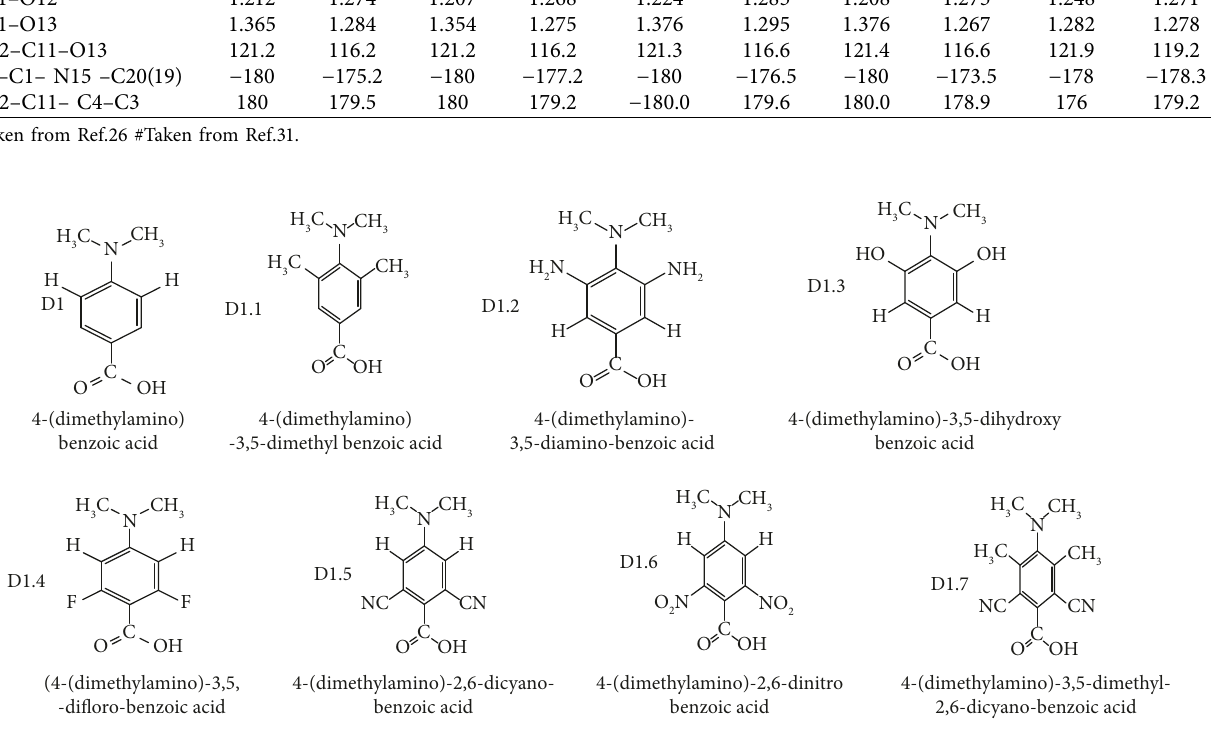
Table 1: Some selected bond lengths (˚A) bond angles ( ° ) and dihedral angles ( ° ) of gas-phase 4-DMABA (D1) and 4-DMABA-T +4 (OH) (D2) which were calculated by using B3LYP, CAM-B3LYB, PBEPBE, ω B97XD functionals, and 6–311++G ∗∗ basis set. B3LYP CAM-B3LYB PBEPBE Parameters